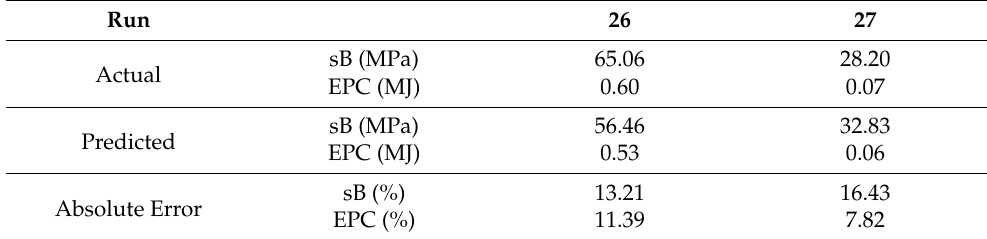
Table 11. Validation